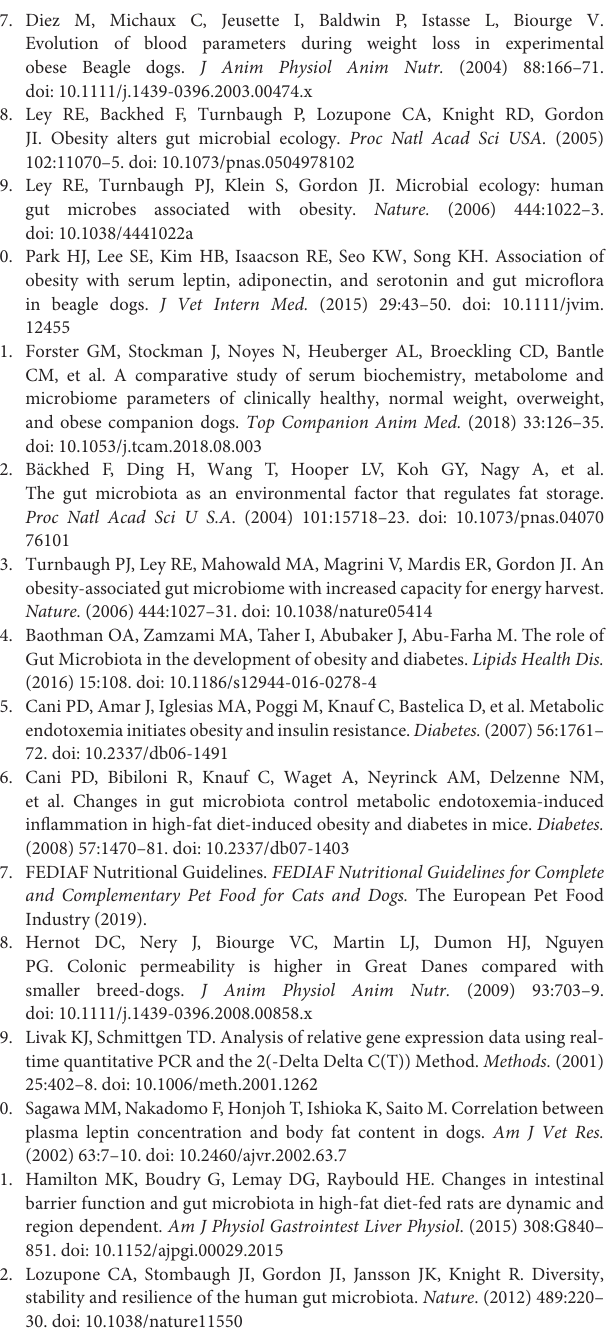
Supplementary Table 1 | Relative abundance of the fecal microbiome in dogs fed the high-fat diet at maintenance (HF-100; n = 8) and at 150% maintenance (HF-150; n = 16) for 8